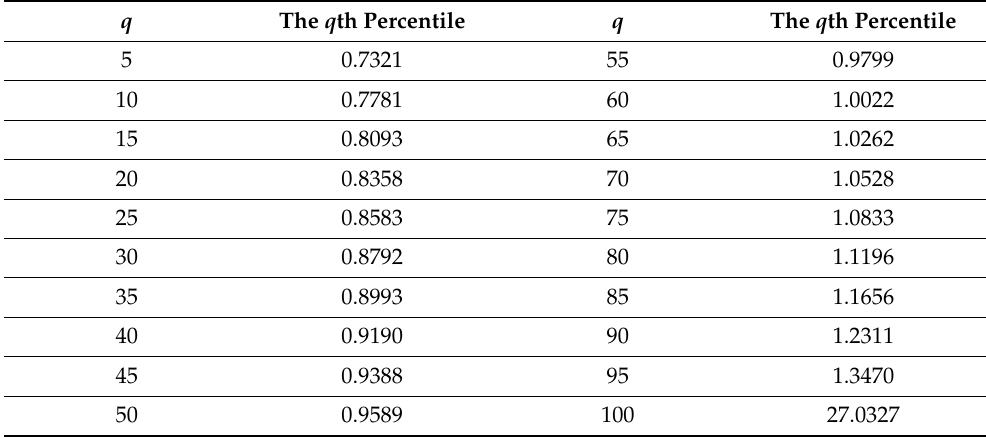
Figure 3. The histogram of 1,836,486 data generated from the fitted kernel density distribution.